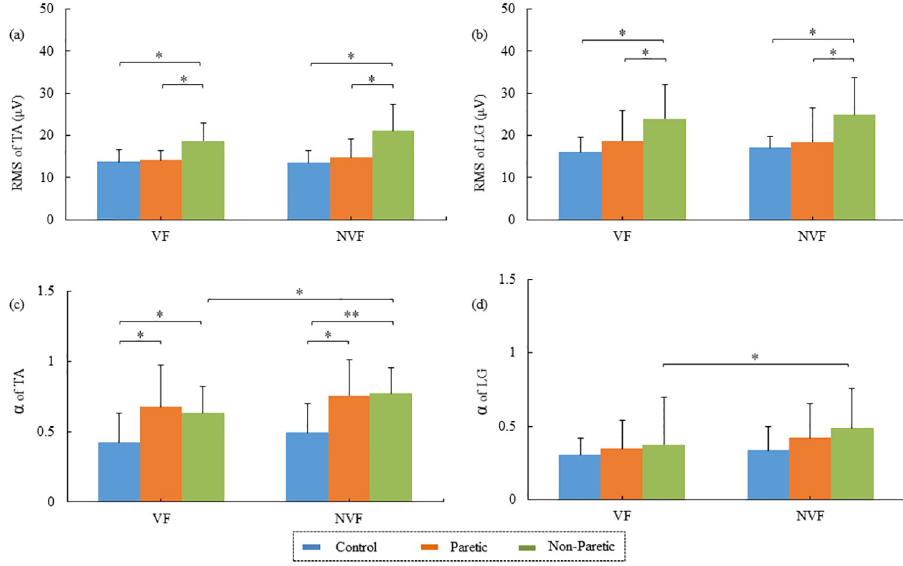
Fig 6. Muscle activations in the hemiplegic and healthy groups. (a) The root mean square (RMS) of tibialis anterior (TA); (b) RMS of LG; (c) scaling exponent ( α ) of TA; and (d) α of LG. � p < 0.05, �� p < 0.001).